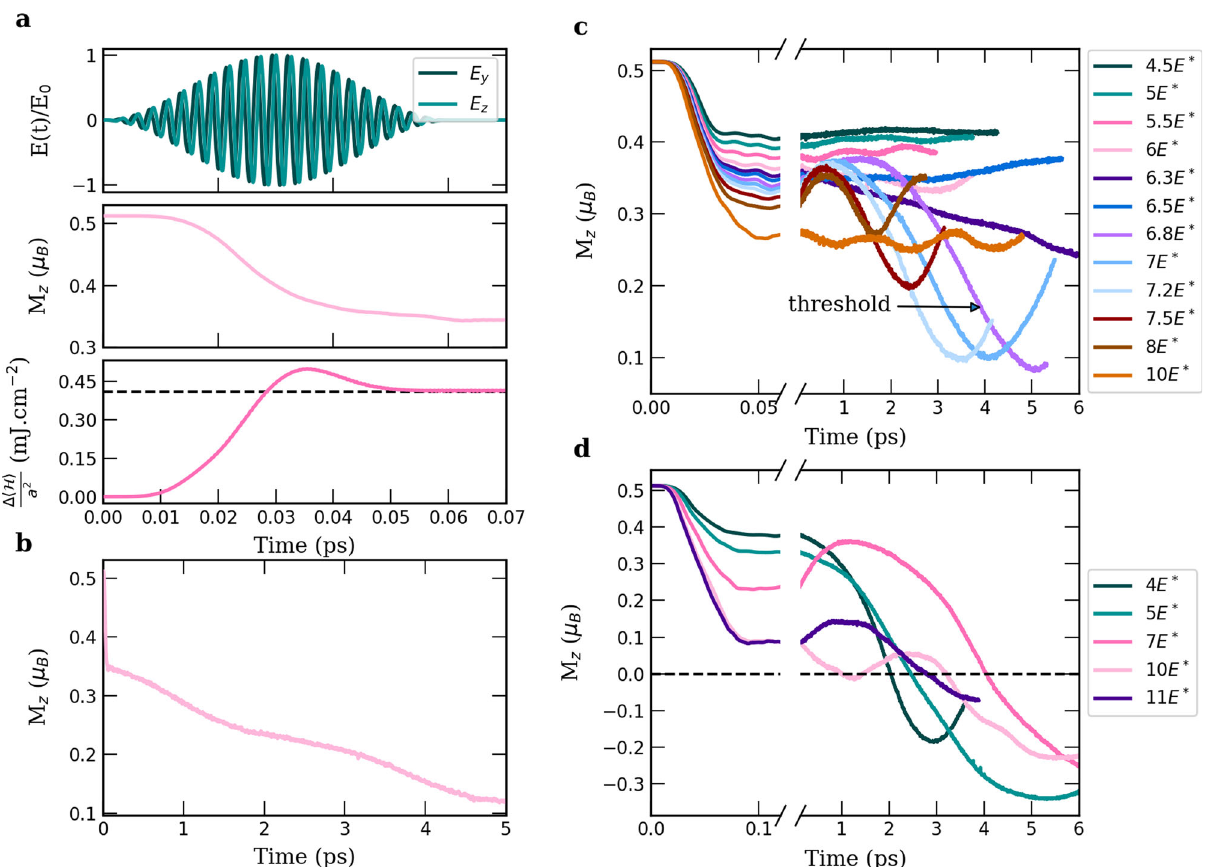
Fig. 2 Diversity of laser-induced magnetization dynamics in bulk Ni. a A 60 fs-wide pulse with the intensity of E 0 = 6 E * , the demagnetization ( M z ) in Bohr magneton ( μ B ) that it induces, and the energy ( 4 H a ) absorbed during its application where a is the lattice constant. The x -axis in all sub- fi gures represents 2 the integration time in picoseconds. b Evolution of the M z component for longer times. c Demagnetization curves for a 50 fs-wide pulse with different laser fi eld intensities. d Switching is observed for a 100 fs-wide pulse for different laser fi eld intensities. The reference value for the laser fi eld intensity is E * = 9.7 × 10 8 V m − 1